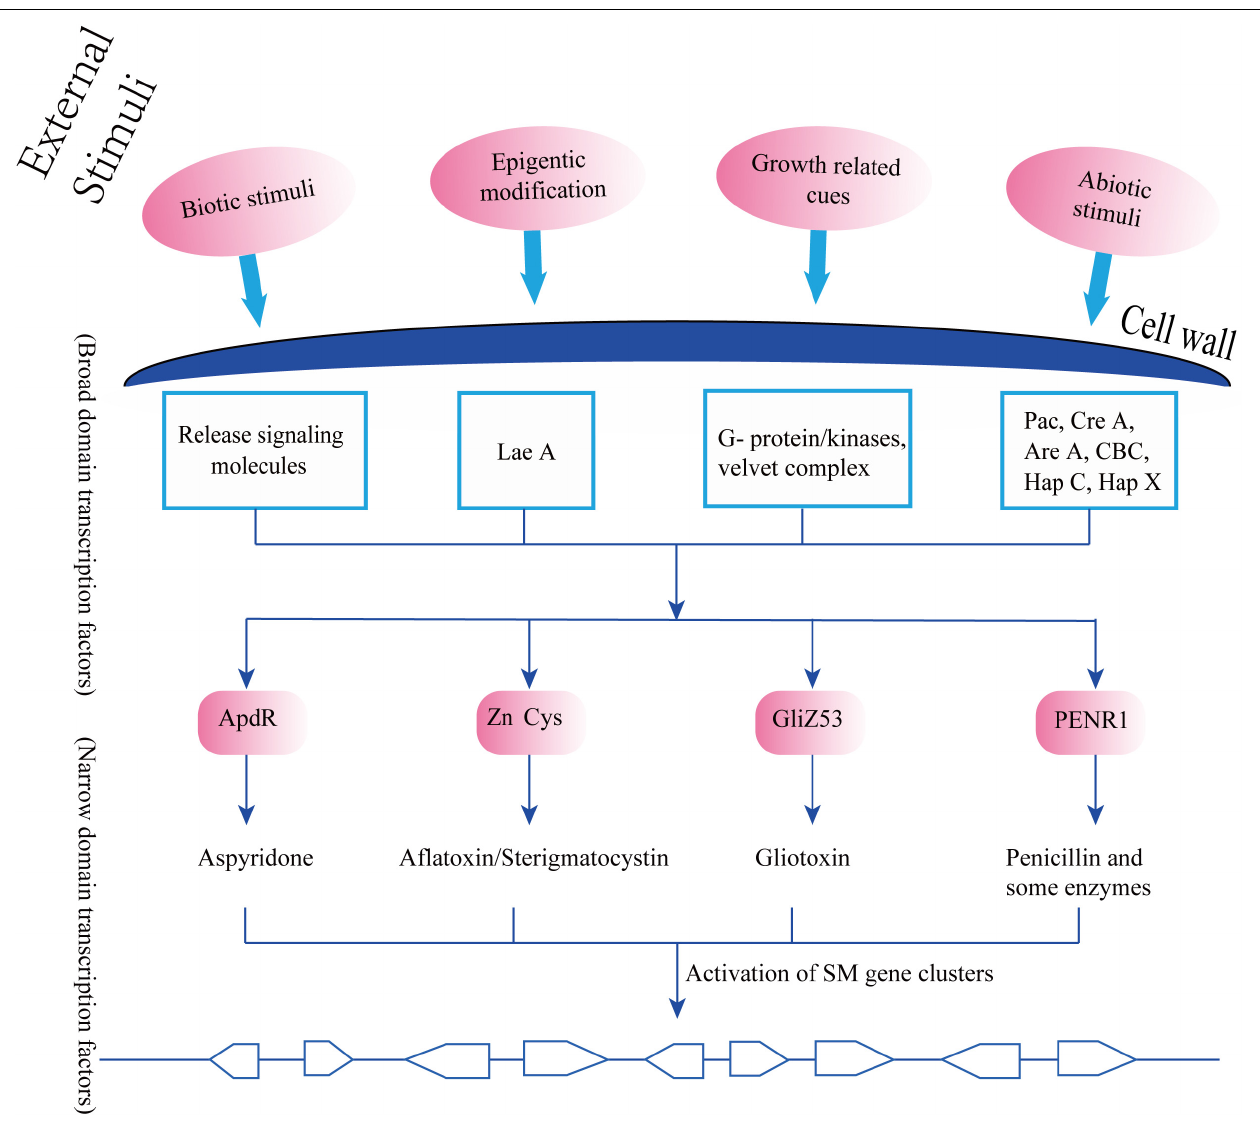
FIGURE 3 | Synchronized regulatory model of secondary metabolites (SMs) biosynthesis and external/morphological